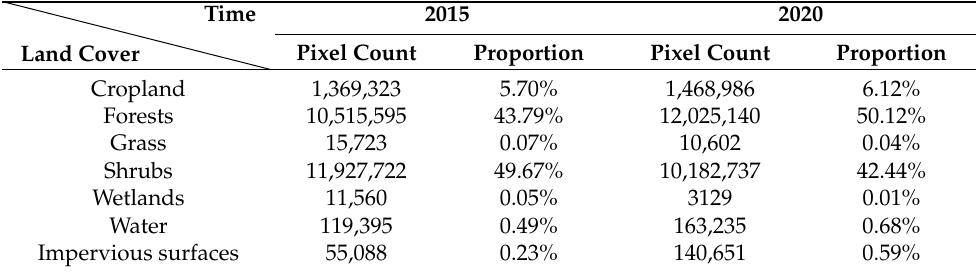
Table 5. Statistical table of GLC_FCS30 products in two phases (2015 and 2020).